Question: Describe this figure in one sentence.
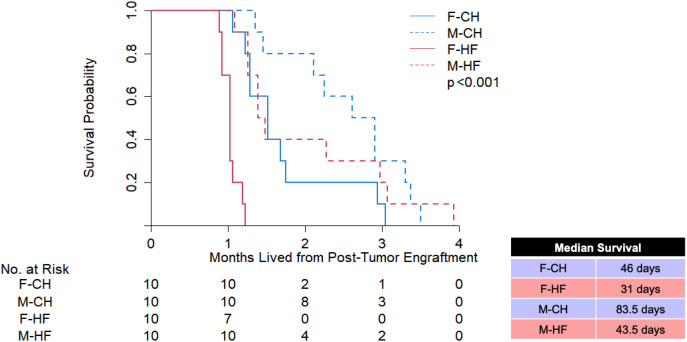
Answer: Effect of diet modulation on CLL survival. Kaplan-Meier survival analysis of all diets over the course of the study (F-CH, n = 10; F-HF, n = 10; M-CH, n = 10; M-HF, n = 10). P < 0.001. Calculated median survival time (days) is provided within the same figure panel. Multivariable Cox proportional hazards model comparing the effects of gender and diet on days-to-event is provided in Supplementary Table 2 . F-CH, female chow; F-HF, female high-fat; M-CH, male chow; M-HF, male high-fat.